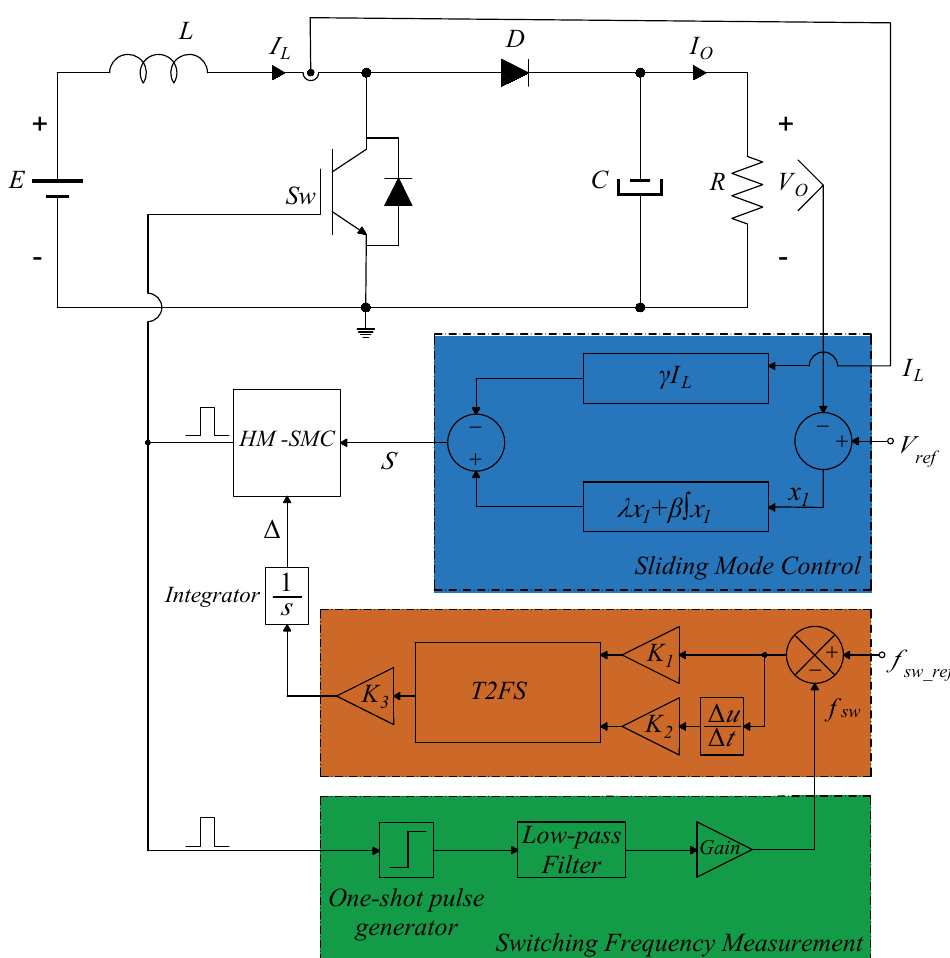
Figure 6. Block diagram of the